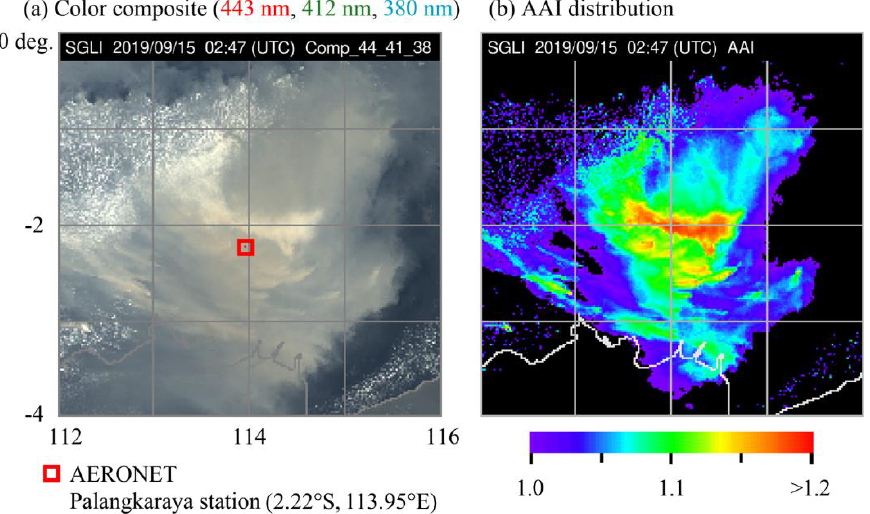
Figure 4. Wildfire events observed from the second-generation global imager (SGLI) over Kalimantan, Indonesia on 15 September 2019. ( a ) Color composite image. ( b ) absorbing aerosol index (AAI) distribution.